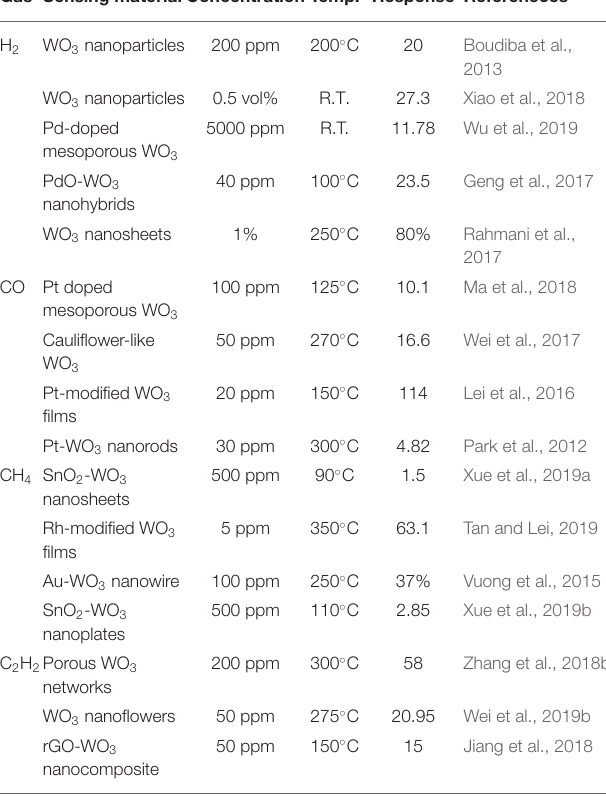
TABLE 1 | Summary of recent researches on WO 3 based sensors for sensing of fault characteristic gases dissolved in transformer oil. Gas Sensing material Concentration Temp. Response